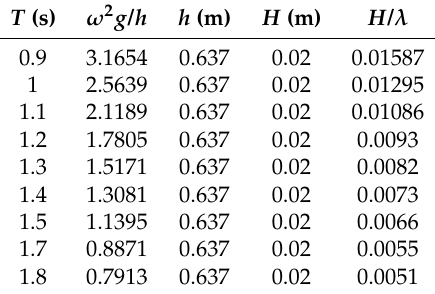
Table 1. Wave parameters in this